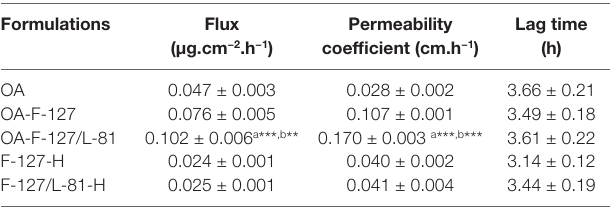
TABLE 3 | Curcumin permeation parameters across Strat-M ® membranes from organogel formulations. Formulations